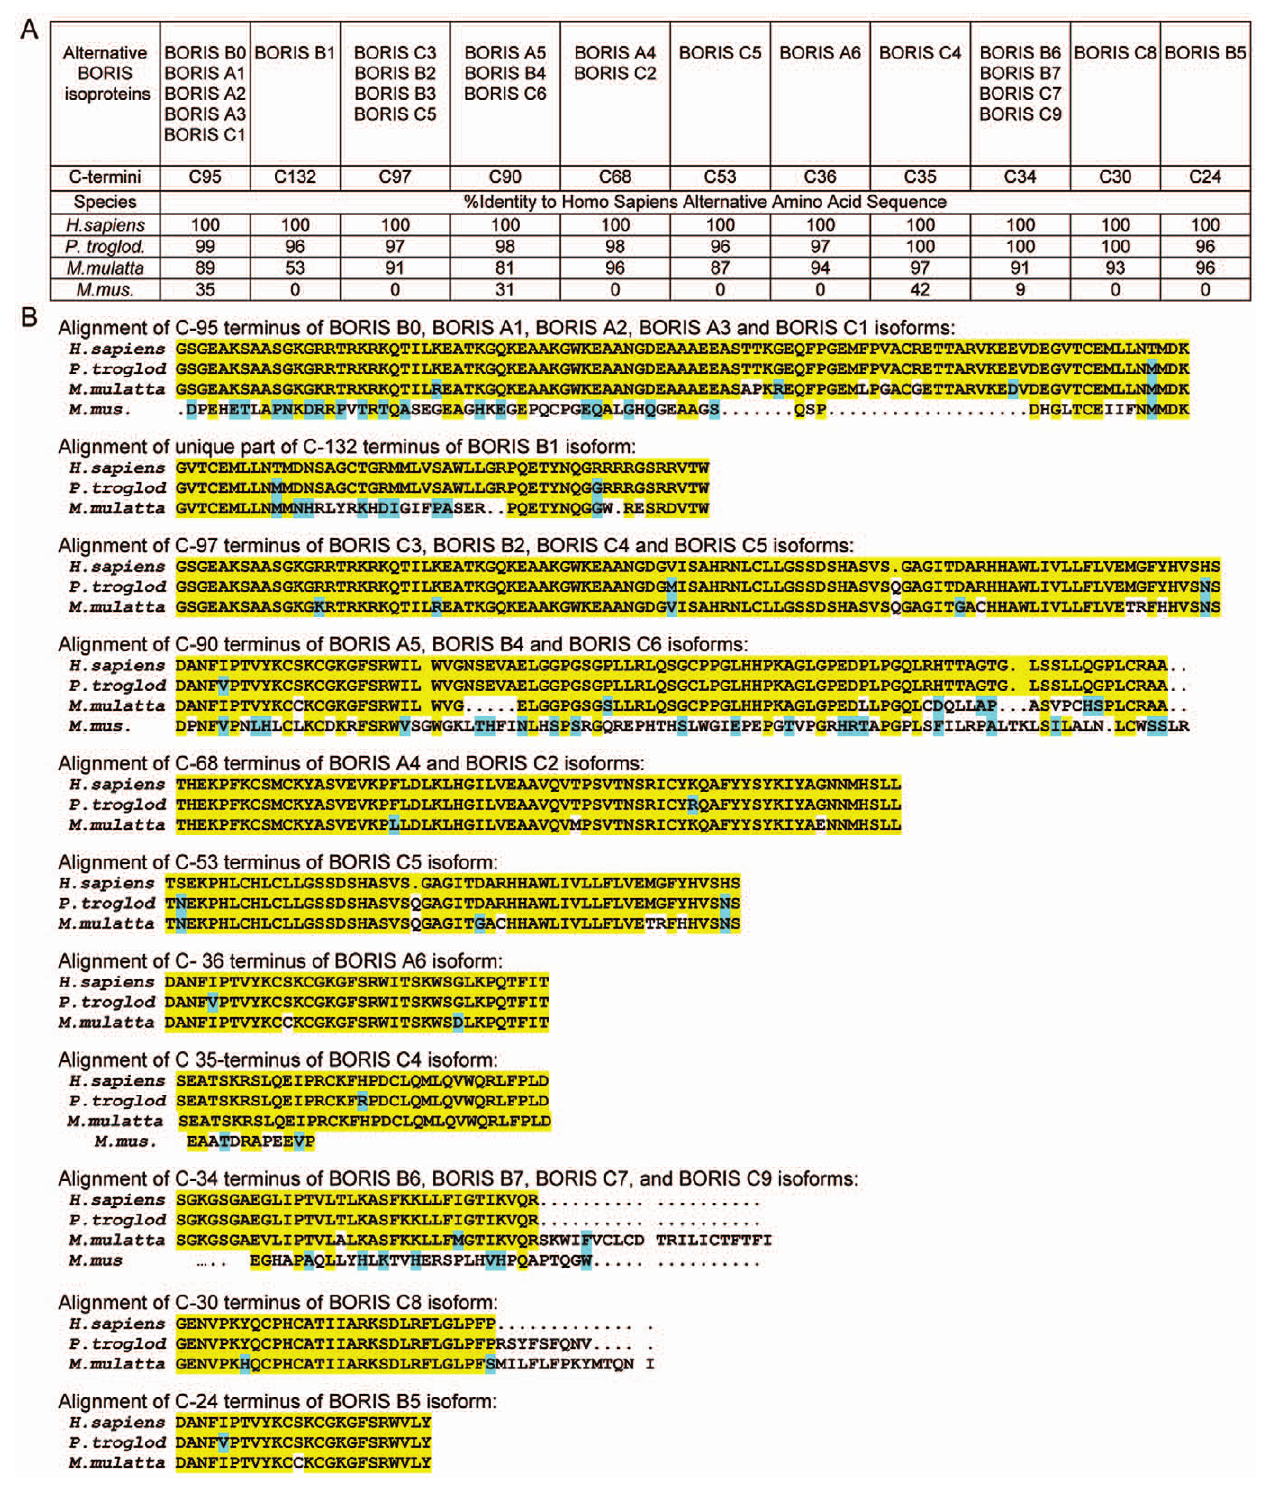
Figure 3. Human BORIS isoform amino acid sequences are evolutionarily conserved in primates. ( A ) Percent identity of human ( H.sapiens ) BORIS isoforms C-termini to putative alternative amino acid sequences those of chimpanzee ( P.troglod. ), macaque ( M.mulatta ), and mouse ( M.mus .). Eleven alternative C-termini found in distinct isoforms are defined by the number of codons downstream of the last ZF. The table shows names of BORIS isoforms with corresponding C-termini and their identity in percent. ( B ) Alignment of BORIS alternative C-termini in human, chimpanzee, macaque and mouse. The alternative amino acid sequences of human, chimpanzee, macaque and mouse are aligned by ClustalW (Vector NTI). Human BORIS splice variants are highly conserved in primates, but not in mice. Amino acid sequences for some of BORIS alternative C-termini (C132, C97, C68, C53, C36, C30, C24) are completely absent in mice. Yellow highlighted sequences are 100% identical to the human amino acid sequence; the blue highlight indicates conservative substitutions relative to human homologous BORIS sequences. Dots indicate insertions or deletions. doi:10.1371/journal.pone.0013872.g003 PLoS ONE |